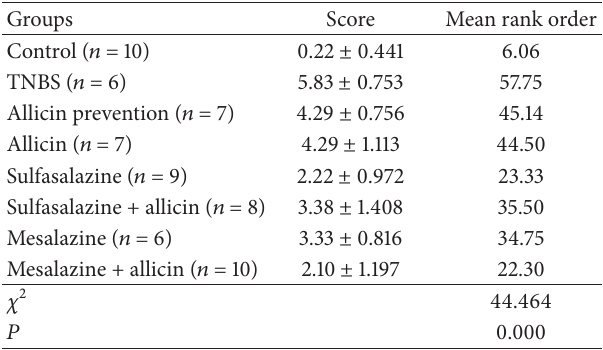
Table 1: Histological scores of colon tissues ( 𝑥 ± 𝑆